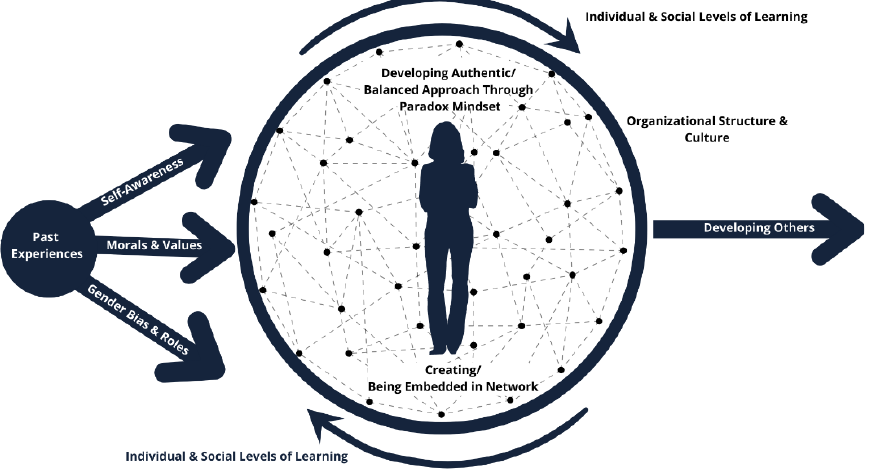
Figure 2. Developing Authentic Women’s Leadership Model.